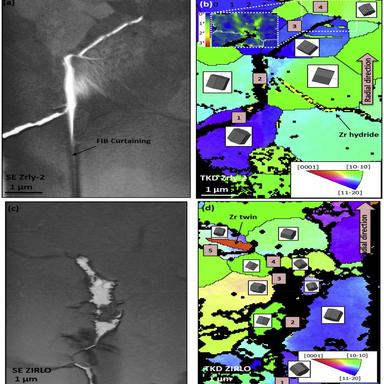
Secondary electron images and TKD orientation maps in IPF jj axial direction colouring for crack tip regions from (a), (b) tested irradiated Zircaloy-2 and (c), (d) C-ring tested ZIRLO. (b) inset shows local misorientation of outlined crack tip region. The original radial direction of the cladding tube is marked on each map, the maximum tensile stress is assumed to be approximately perpendicular to the radial direction in both experiments.